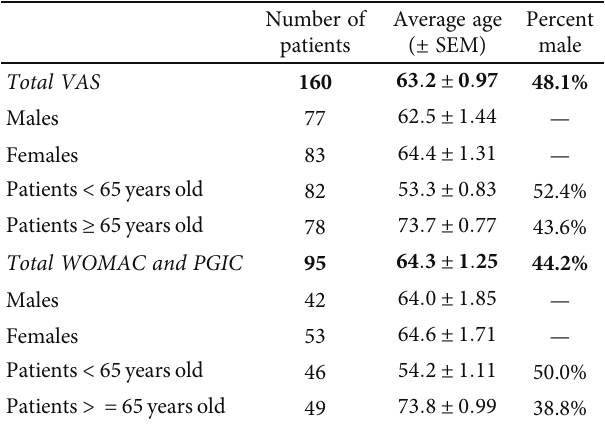
Table 1: Patient demographics for the 160 total patients enrolled in the VAS portion of the study. The demographics are also listed for the subgroup, 95 total patients, of this population for which WOMAC and PGIC scores were